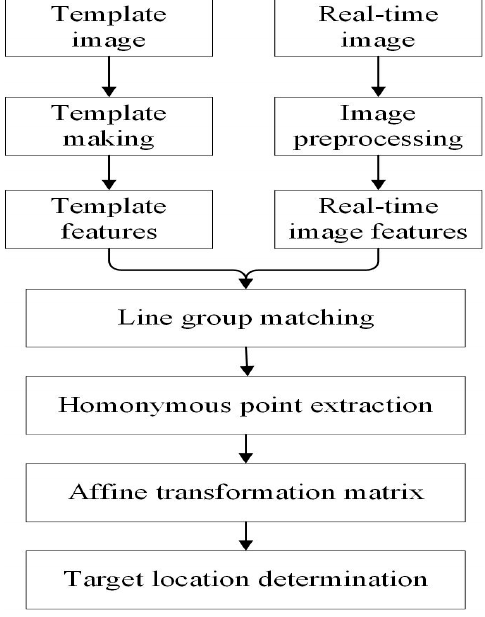
Figure 8. Flow chart of automatic target recognition.